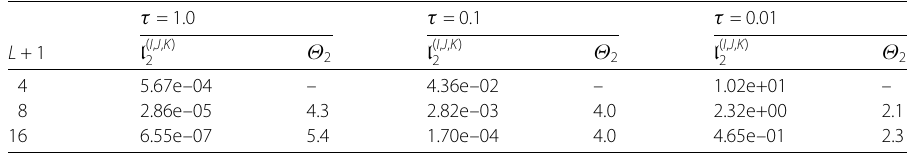
Table 1a Errors and order for UM-FOCS in Example 5.1